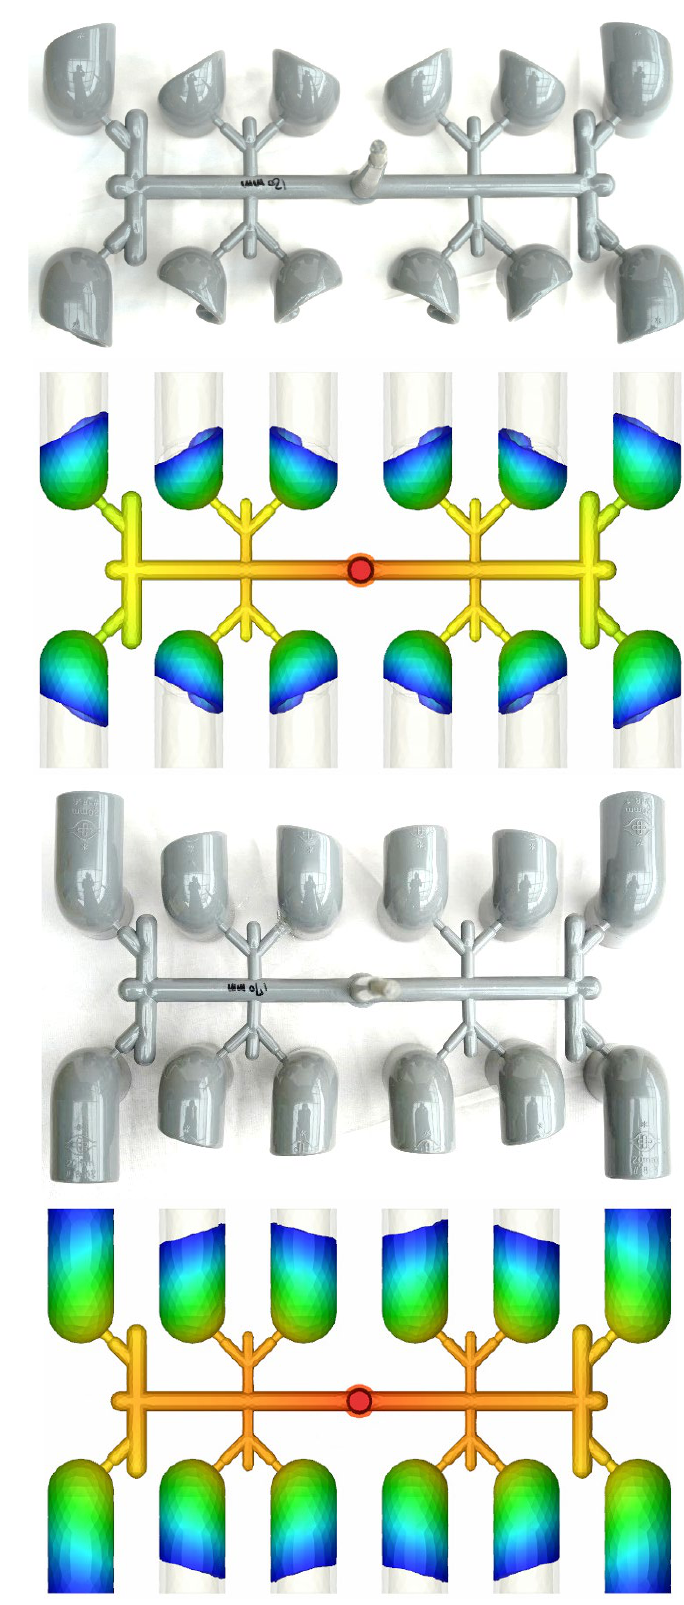
Figure 3. Top views of experimental and numerical comparisons of PVC fittings and runners by short-shot testing: ( a ) experimentally 75% filled parts; ( b ) numerically 75% filled flow front; ( c ) experimental imbalanced-fill parts; ( d ) numerical flow front of imbalanced-fill parts. Table 2. Injection molding parameters of Suspension S-60 PVC.